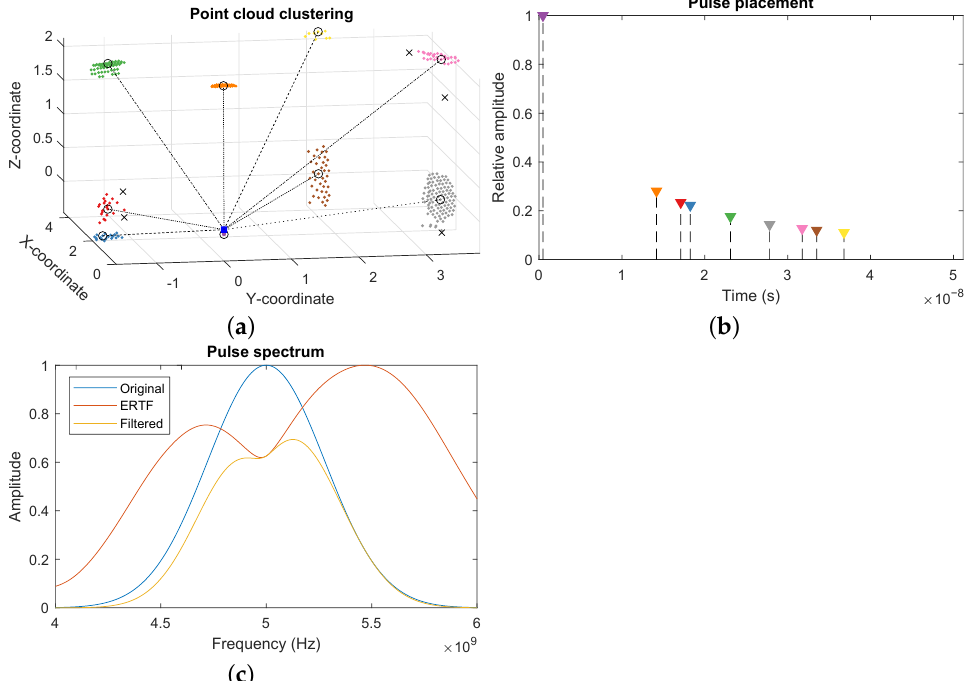
Figure 4. Steps of the reflector point cloud processing in MATLAB. ( a ) The point cloud received from the Unreal engine and clustered by the density-based spatial clustering of applications with noise (DBSCAN) algorithm. Clusters are color-coded, cluster centers are marked with circles, outliers are represented by crosses. The sensor location is draw as a blue square. ( b ) Pulse placement and amplitude in the generated signal according to the reflector location and ray attenuation. ( c ) Filtering of a pulse by the emitter and receiver for a specific incoming